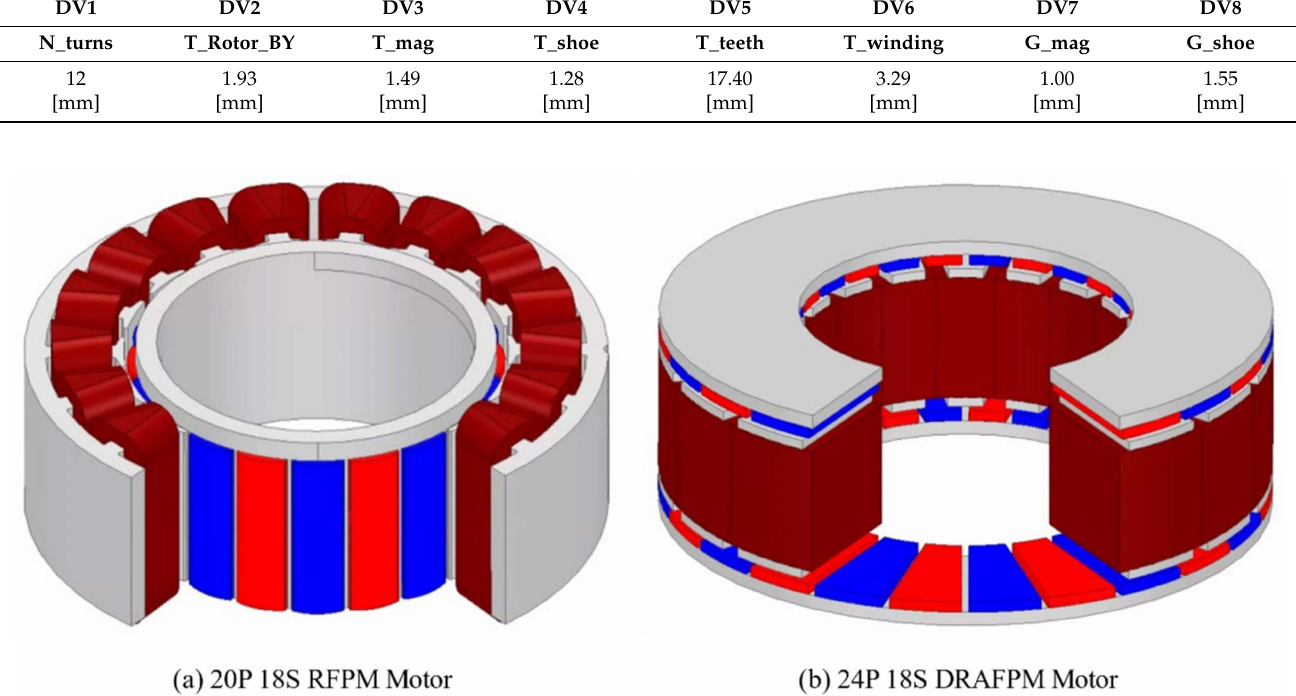
Figure 21. Shape of final DRAFPM motor and target RFPM motor